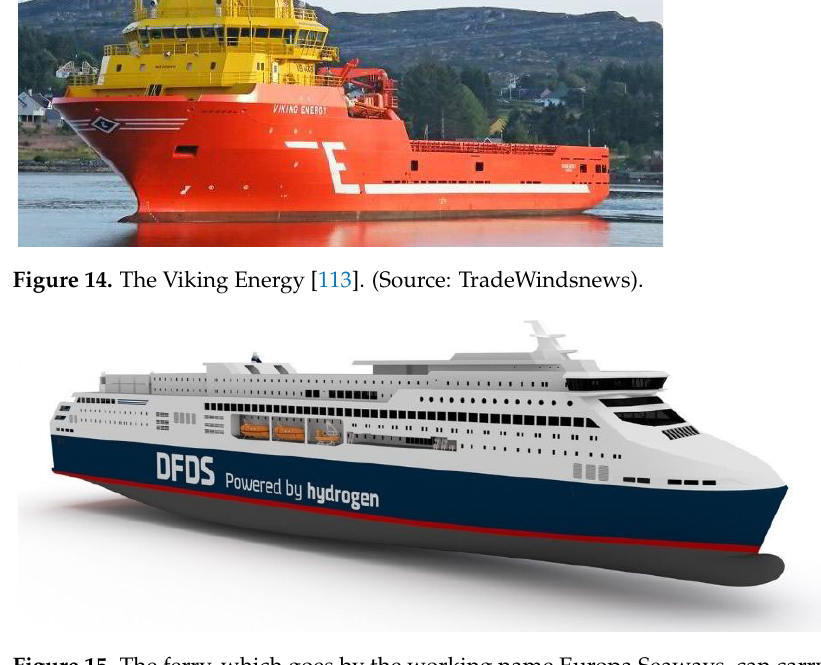
Figure 15. The ferry, which goes by the working name Europa Seaways, can carry 1800 passengers and 120 trucks or 380 automobiles